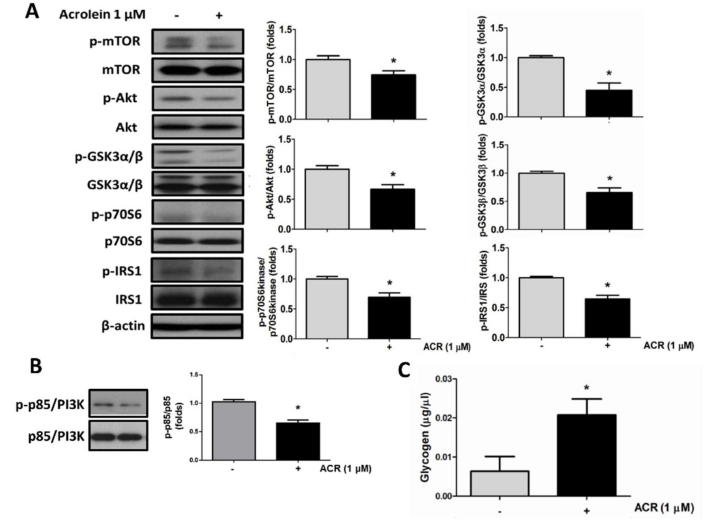
Figure 3. Acrolein interferes with glucose metabolic signaling molecules in differentiated C2C12 myotubes. Myotubes were treated with 1 µ M acrolein for 24 h. ( A ) The levels of phosphorylated and total protein expression of IRS1, Akt, mTOR, p70S6K, and GSK3 α / β were determined by Western blotting and quantified using densitometric analysis. ( B ) The levels of phosphorylated and total protein expression of p85/PI3K were determined by Western blotting and quantified using densitometric analysis. ( C ) The glycogen contents in myotubes treated with acrolein (1 µ M) for 72 h are shown. Results are represented as means ± SEM for at least four independent experiments. * p < 0.05 versus vehicle